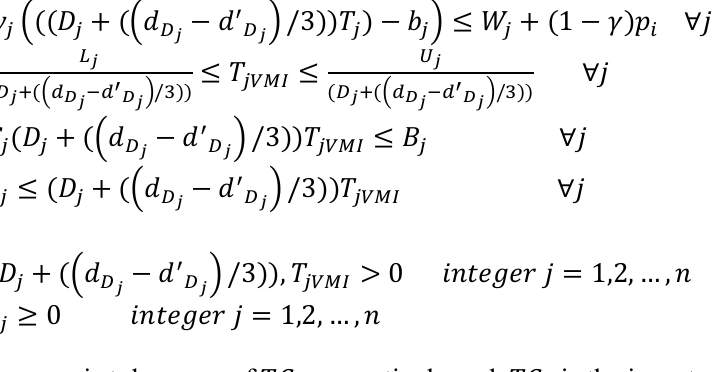
Initial data of the examples